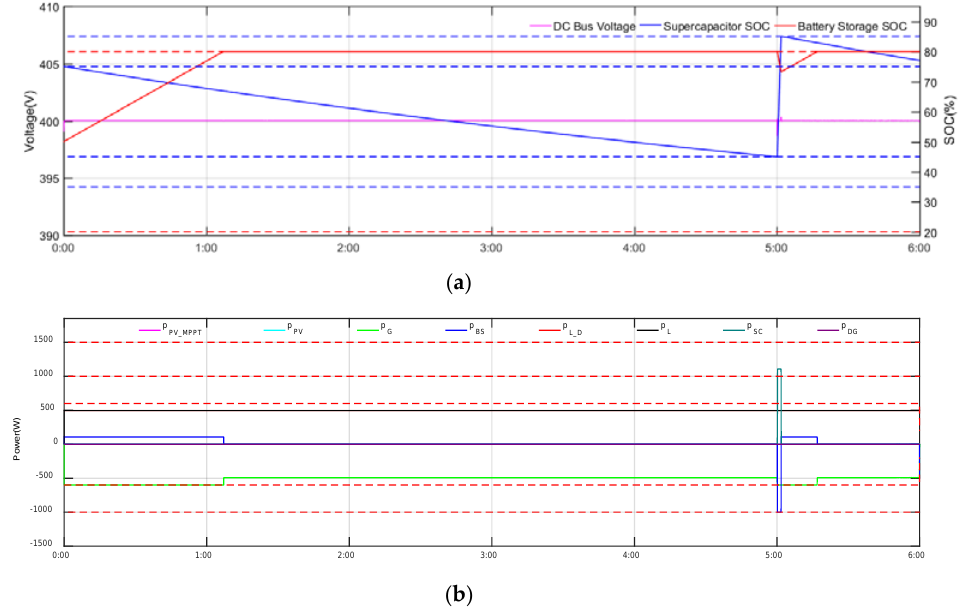
Figure 8. Curves of common DC bus voltage and SOC of storage ( a ) and curves of power ( b ) during the period 0:00–6:00.